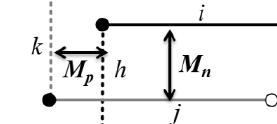
Figure 4. Conflicted matching pairs detection